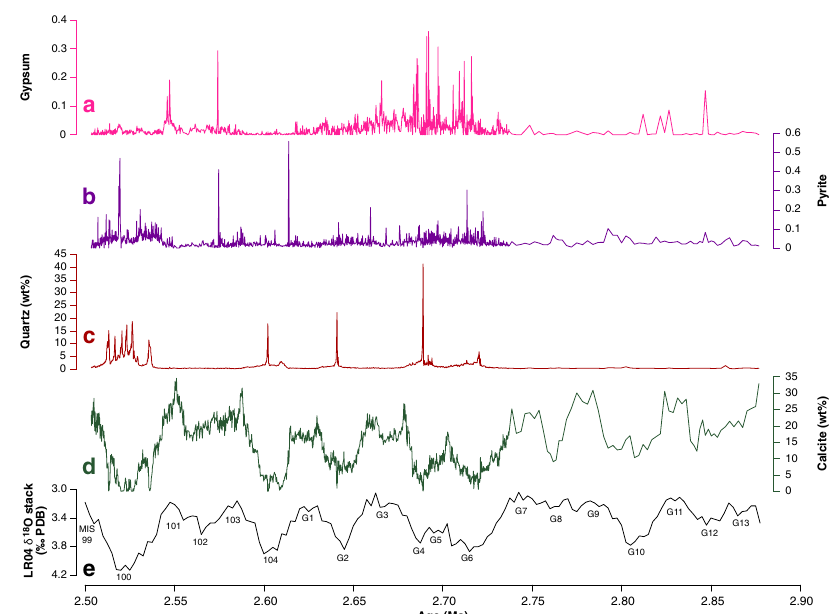
Fig. 9 Glacial – interglacial variations in relative amounts of gypsum, pyrite, quartz, and calcite revealed by XRD analysis. a , b Amounts of gypsum and pyrite. Because the amounts of the gypsum and pyrite were small, they were represented by values of their representative diffraction peaks to that of zincite (internal standard). c , d Weight percentages of quartz and calcite. e LR04 global δ 18 O stack 16 .